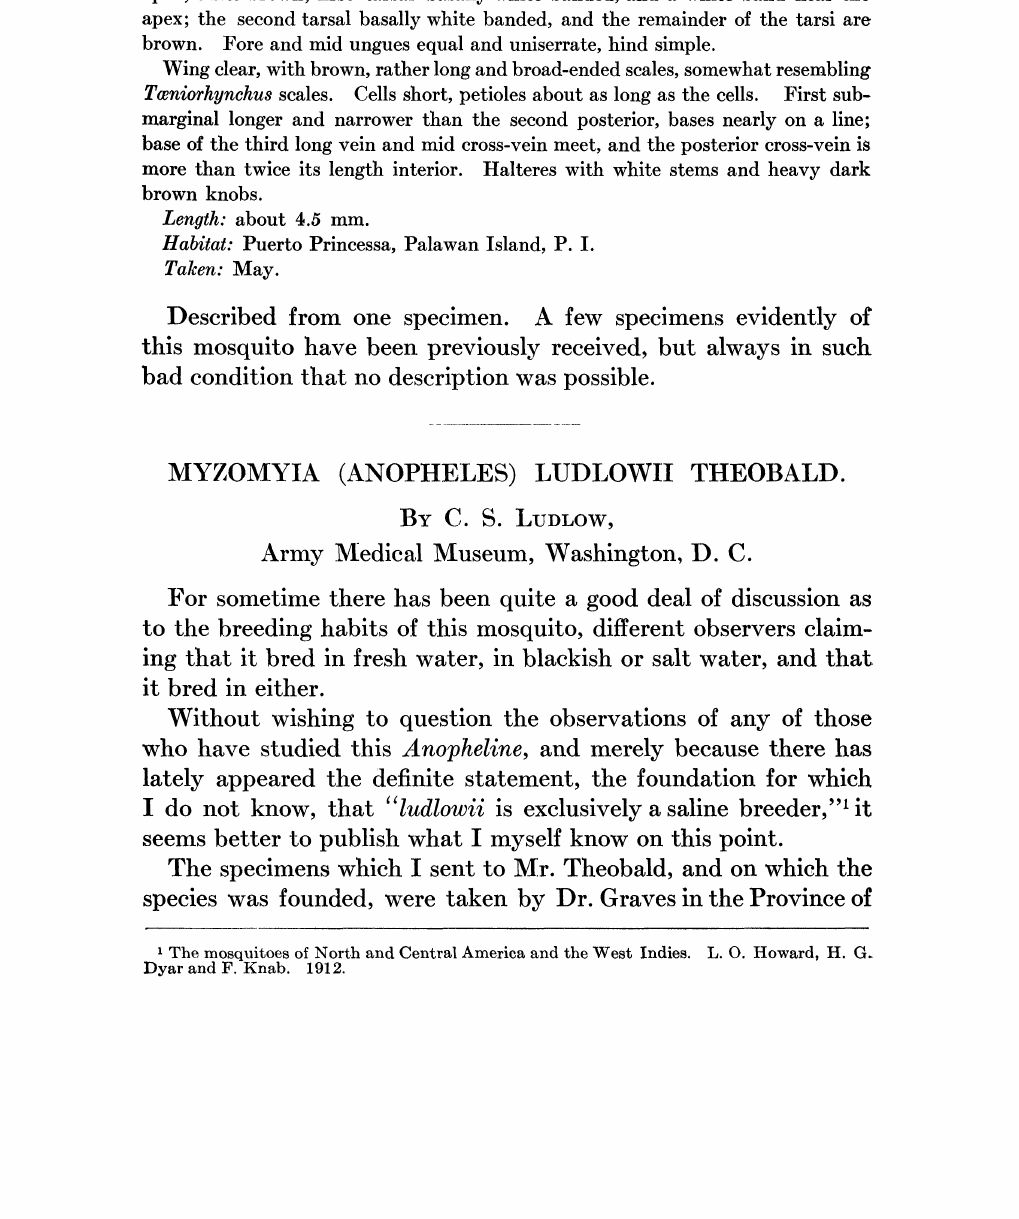
brown. On the femora of the mid legs the ventral white extends on the dorsal aspect to form a white spot near the apex, the very tip being brown; the tibia are brown except a white spot near the apex, the very tip being brown; first tarsal is basally white bands and has a white band near the apex, the tip being brown; second tarsal is basally white banded, the other tarsal joints are brown. The hind femora are silvery white except for a narrow basal brown band, a broad brown band a little beyond the mid-length of the femora, and a narrow brown band at the apex; tibiae brown; first tarsal basally white banded, and a white band near the apex; the second tarsal basally white banded, and the remainder of the tarsi are brown. Fore and mid ungues equal and uniserrate, hind simple. Wing clear, with brown, rather long and broad-ended scales, somewhat resembling Tteniorhynchus scales. Cells short, petioles about as long as the cells. First sub- marginal longer and narrower than the second posterior, bases nearly on a line; base of the third long vein and mid cross-vein meet, and the posterior cross-vein is more than twice its length interior. Halteres with white stems and heavy dark brown knobs. Length: about 4.5